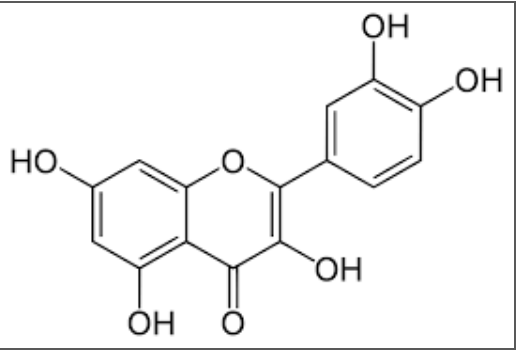
Figure 4. Chemical structure of :A. hesperidin B. hesperitin (60)